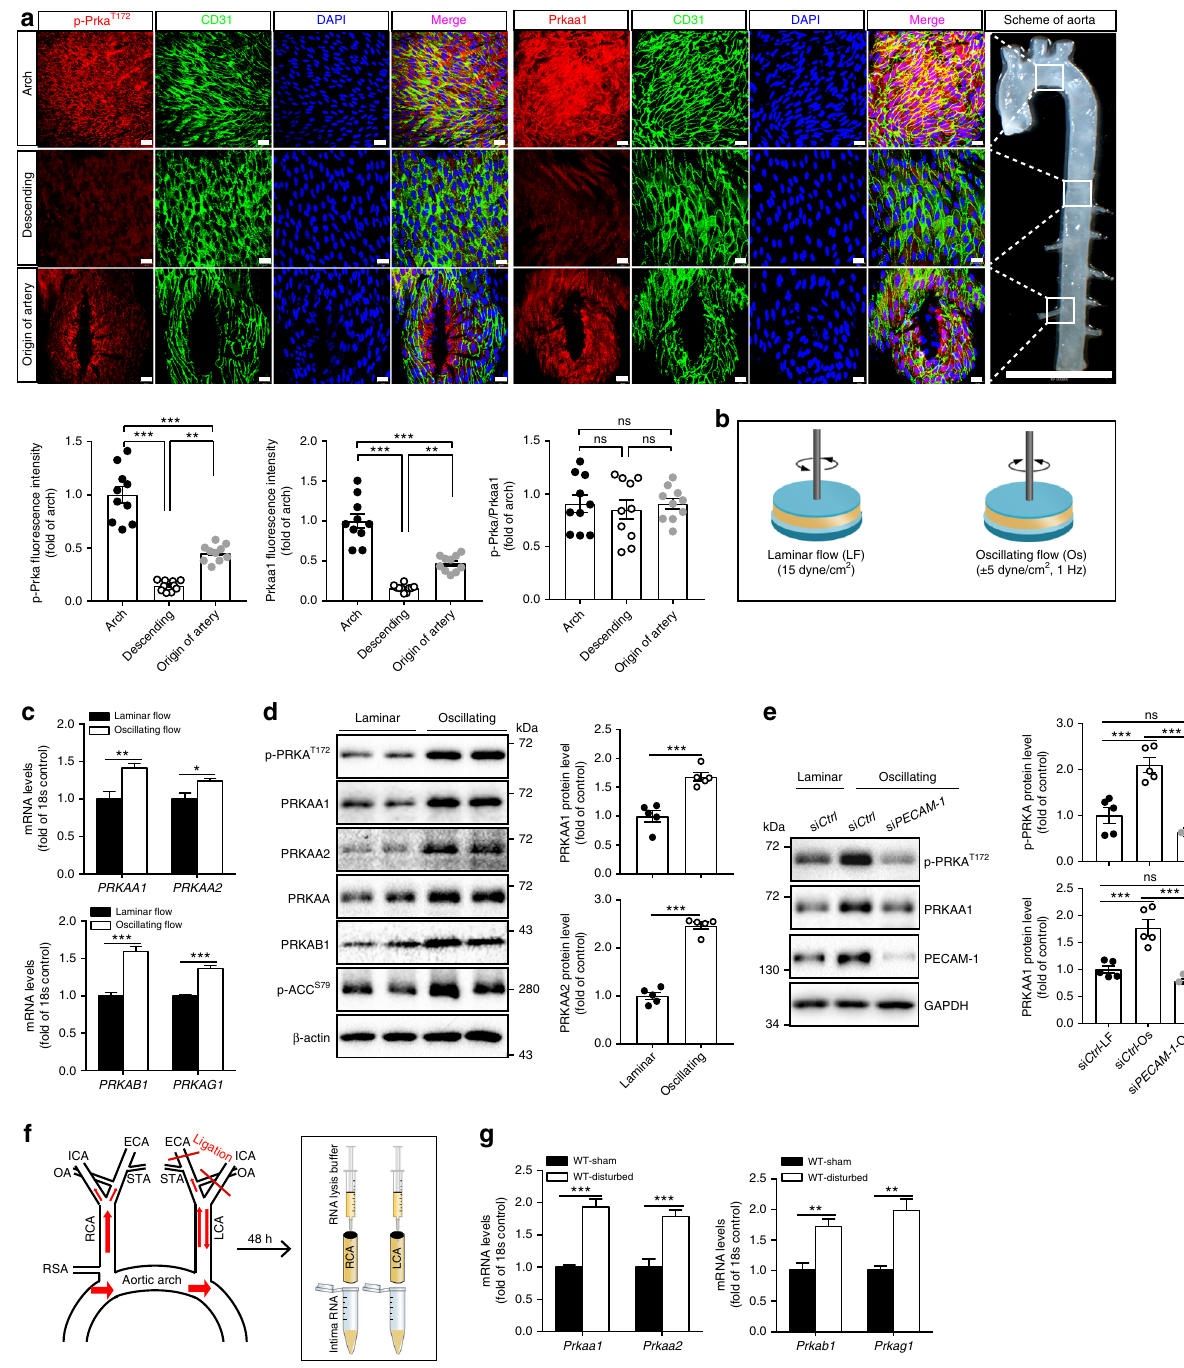
Fig. 1 Increased expression of Prkaa1/AMPK in ECs exposed to disturbed fl ow. a Representative images of en face immuno fl uorescence staining and quanti fi cation data of pPrkaa1 (Thr172) and Prkaa1 (red) levels in the arterial endothelium of C57BL/6j mice. The endothelium was visualized by CD31 staining (Alexa Fluor-488, green), and nuclei were counterstained with DAPI (blue). Images were captured with confocal fl uorescence microscopy. Scale bar: 20 µ m; n = 10 mice per group. Boxes in image on the right indicate origin of regions shown in the respective rows of images (scale bar: 5mm). b Schematic illustration of laminar fl ow (shear stress: 15 dyne/cm 2 ) and oscillating fl ow (shear stress: ± 5dyne/cm 2 , frequency: 1 Hz) systems in vitro. c Real-time PCR analysis of mRNA levels of PRKAA1, PRKAA2, PRKAB1 , and PRKAG1 in HUVECs under laminar fl ow and oscillating fl ow for 24h. n = 4. d Western-blot analysis and quanti fi cation data of protein levels of pPRKA (Thr172), PRKAA1, PRKAA2, total PRKAA, PRKAB1, and pACC (Ser 79) in HUVECs under laminar fl ow and oscillating fl ow for 24h. β -Actin was used as a loading control. n = 5. e Western-blot analysis and quanti fi cation data of the protein levels of pPRKA and PRKAA1 in HUVECs transfected with si Ctrl and si PECAM-1 under laminar fl ow and oscillating fl ow for 24h. n = 5. f Mouse partial carotid ligation model and intimal RNA extraction steps from carotid arteries following fl ushing arteries with QIAzol lysis reagent. g Real-time PCR analysis of mRNA levels of Prkaa1, Prkaa2, Prkab1 , and Prkag1 in ECs obtained from sham-operated right common carotid arteries and partially ligated left common carotid arteries in C57BL/6j mice. n = 9 mice per group. All data were expressed as mean ±SEM. Statistical signi fi cance was determined by unpaired Student ’ s t -test (for c , d , g ) and one-way ANOVA followed by Bonferroni test (for a , e ). * p < 0.05 was considered signi fi cant, ** p < 0.01, *** p <